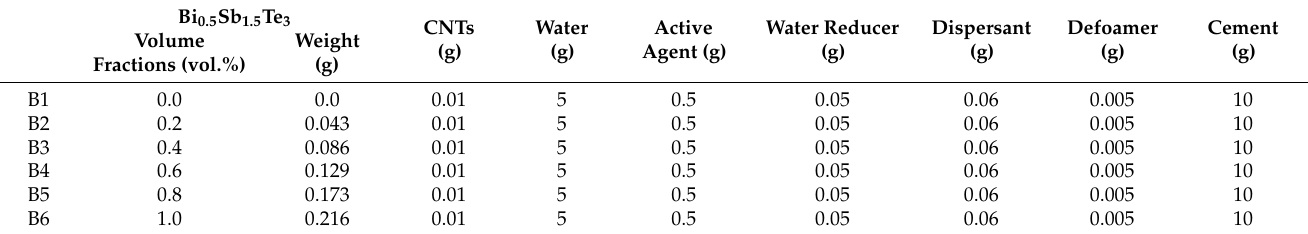
Table 1. The proportions of Bi 0.5 Sb 1.5 Te 3 , CNTs, water, active agent, water reducer, dispersant, defoamer, and cement in the cement pastes.